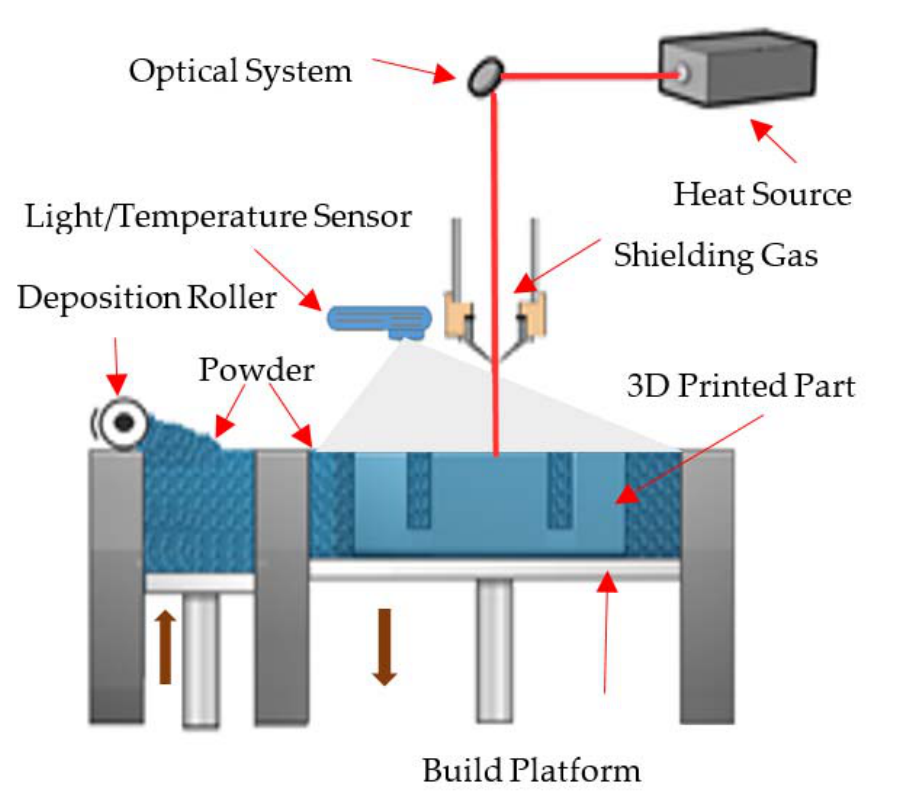
Figure 1. Schematic of the direct metal printing (DMP) mechanism.